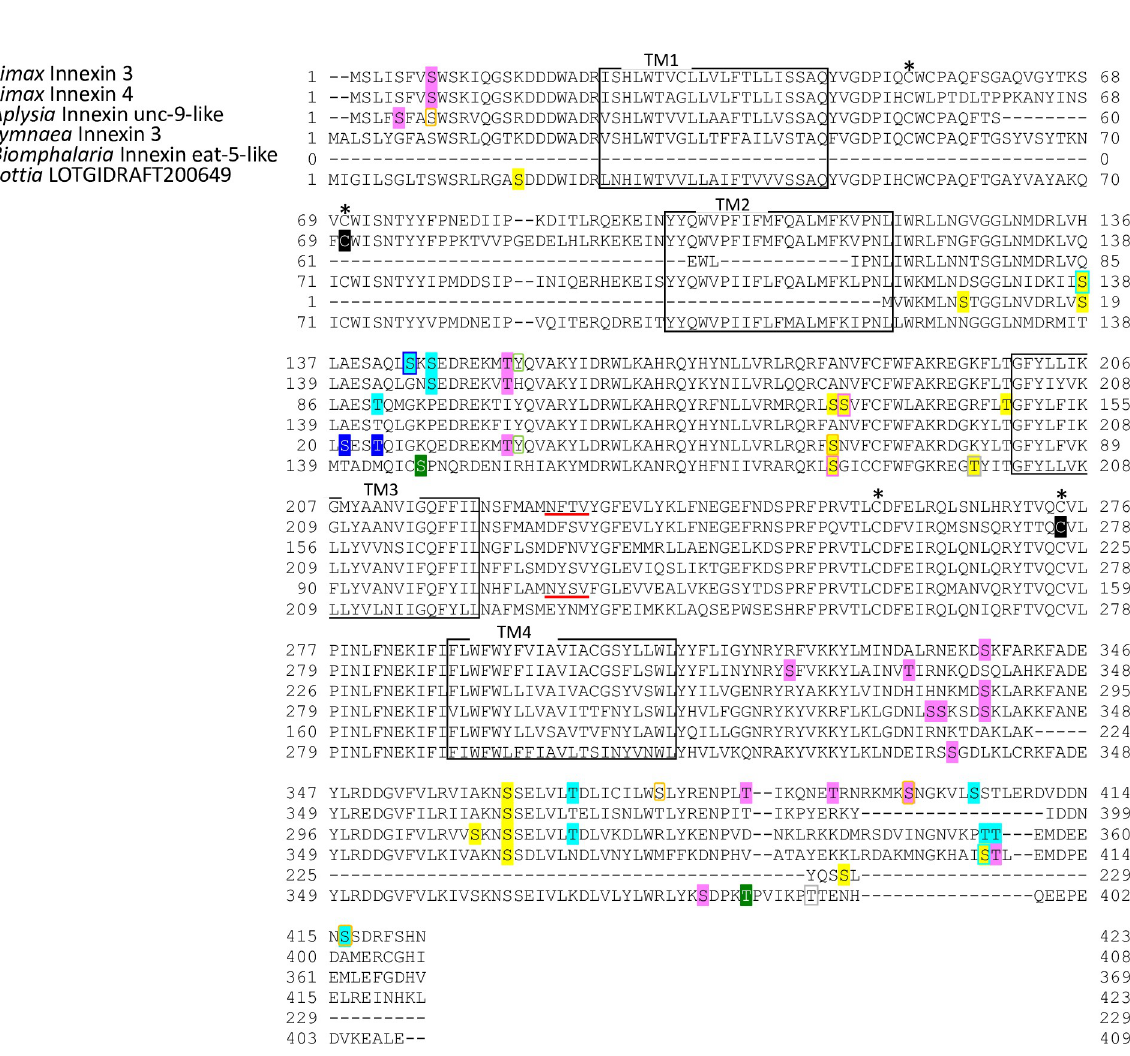
Fig 4. Protein sequence alignment of molluscan innexin orthologs in Group 2. Alignment of deduced amino acid sequences of Limax innexin 3 and 4 with orthologous innexin sequences. The boxes show the four transmembrane domains, while the asterisks indicate the extracellular cysteine residues. The potential S-nitrosylation sites are shaded in black. The phosphorylation sites are indicated with shading or box in magenta (protein kinase C), yellow (protein kinase A), blue (casein kinase 1), cyan (casein kinase 2), orange (P34cdc2), green (p38-mitogen-activated protein kinase), light green (proto-oncogene tyrosine-protein kinase Src), and gray (protein kinase G). Potential N- glycosylation sites are underlined with bold red lines.